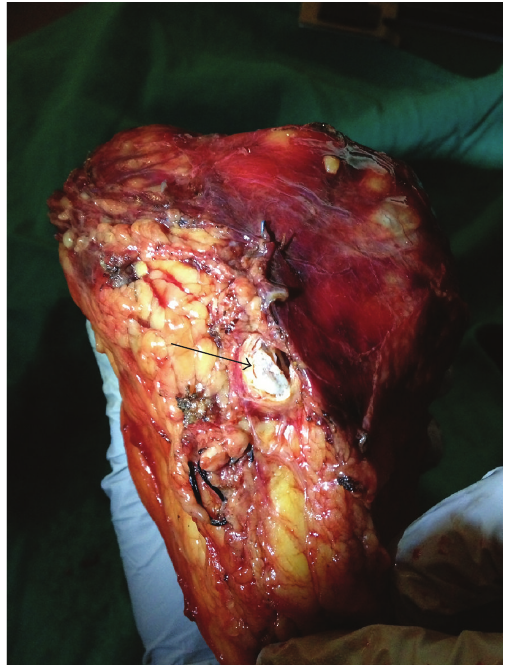
Figure 1: The surgically resected specimen consisted of clear cell renal carcinoma with tumor thrombus (arrow).